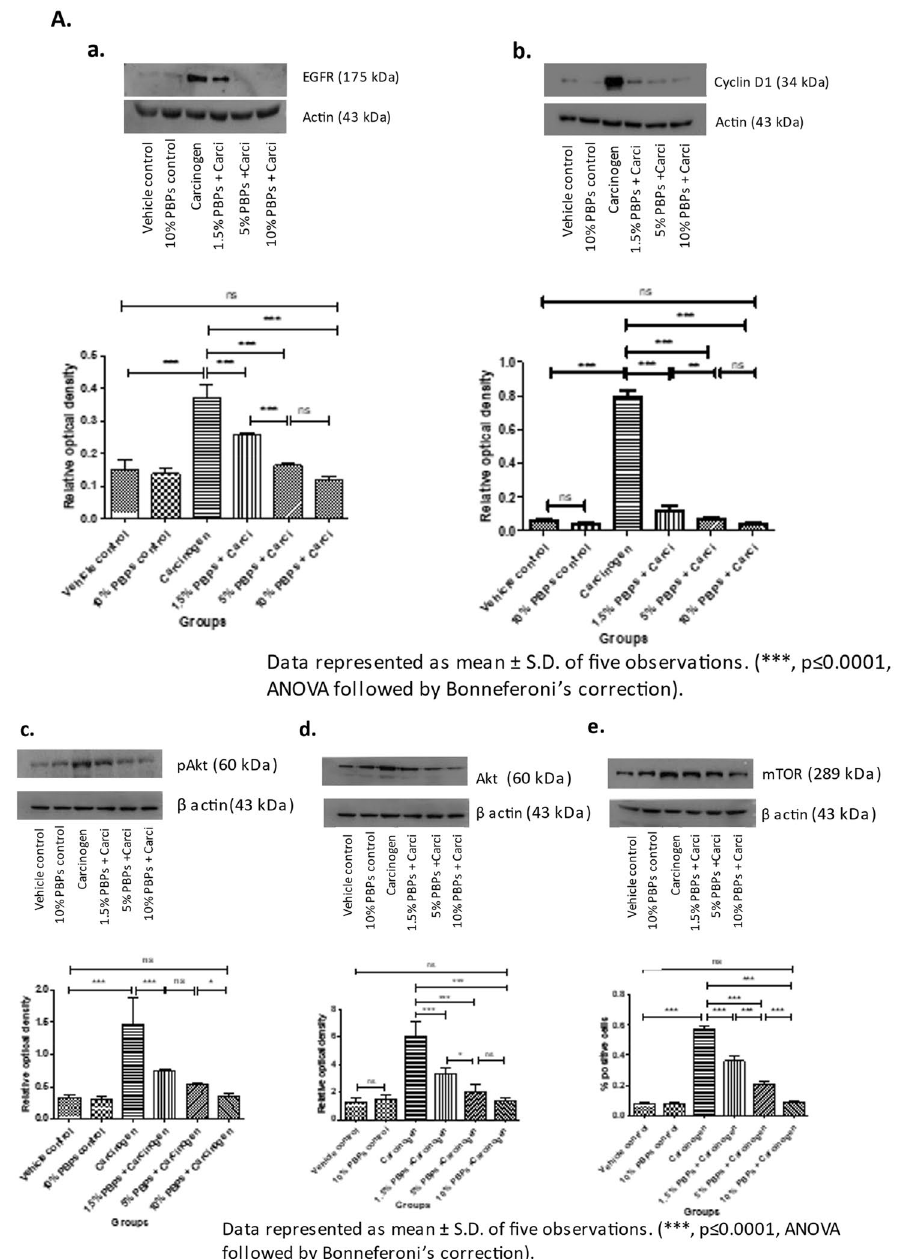
Figure 3. Effect of pre and concurrent treatment of different doses of PBPs on EGFR and its downstream targets in experimental oral cancer. ( A ) Representative blots and relative densitometric levels of ( a ) EGFR, ( b ) Cyclin D1, ( c ) Akt, ( d ) pAkt and ( e ) mTOR. Data represented as mean ± S.D. of five observations. (***, p ≤ 0.0001, ANOVA followed by Bonneferoni’s correction). ( B ) Representative photomicrographs showing immunohistochemical detection of EGFR. Data represented as mean ± S.D. of five observations. (***, p ≤ 0.0001, ANOVA followed by Bonneferoni’s